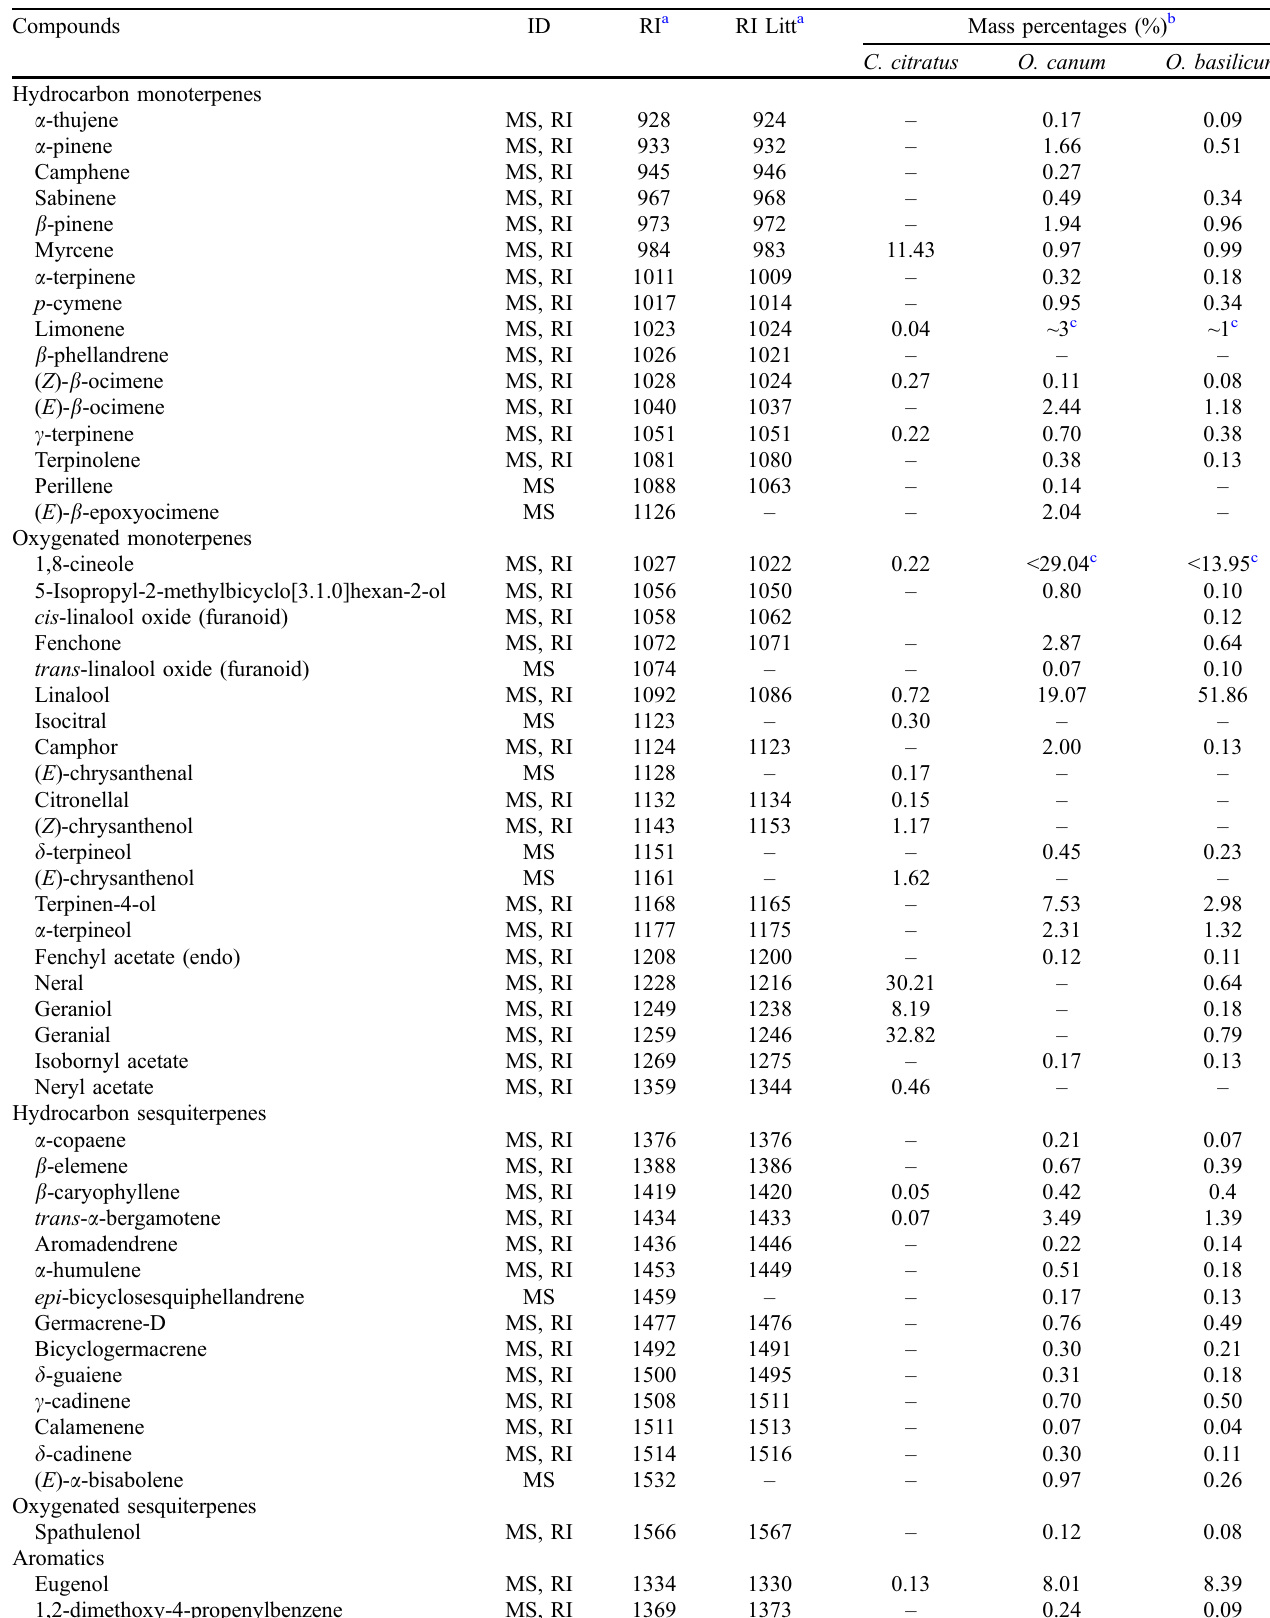
Table 1. Chemical composition of essential oils from leaves of Cymbopogon citratus (DC), Ocimum canum Sims and Ocimum basilicum